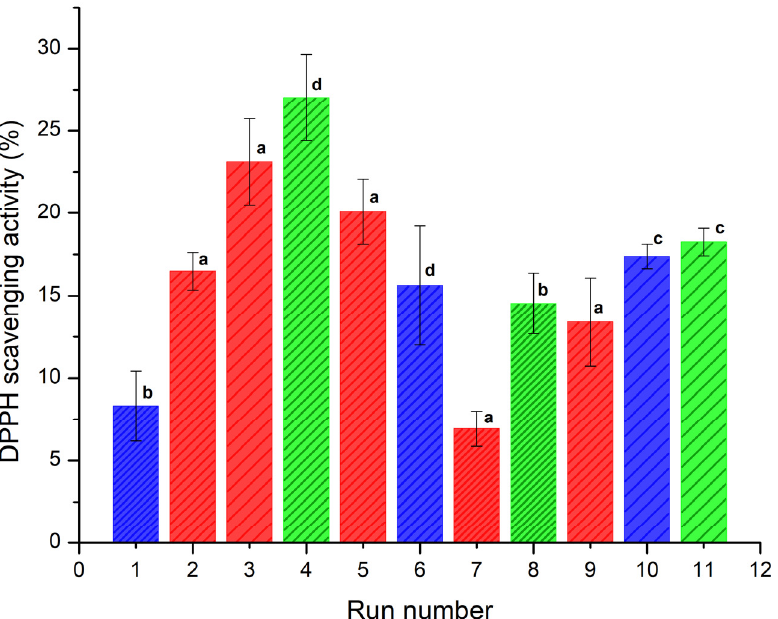
Figure 4. DDPH scavenging capacity (%) of the spray-dried powders containing the active ingredients (INMX_1–11) at 30 min of exposition. Bar color indicates the polysaccharide group (blue for MX, green for IN, and red for blends). Pattern thickness indicates the drying temperature (dense for low temperature, medium for intermediate temperature, and sparse for high temperature). Lowercase letters indicate the Tukey’s test results at significance level of 0.05. a: significance difference, effect of drying temperature; b: significance difference, effect of composition at 150 °C; c: no significance difference, effect of composition at 210 °C; d: significance difference, effect of composition at 180 °C and 28.4% solids.